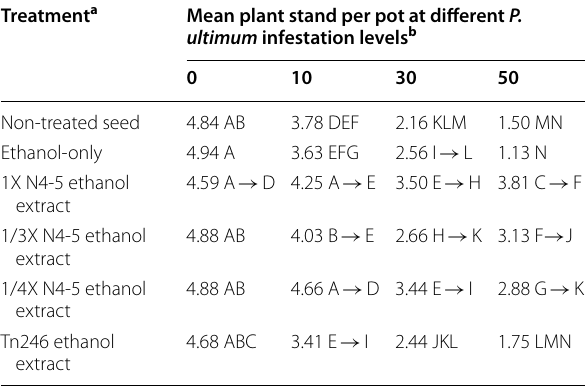
Table 3 Suppression of damping-off of cucumber caused by Pythium ultimum in soil-less mix with ethanol extract from Serratia marcescens strains N4-5 and Tn246 normalized on a total protein